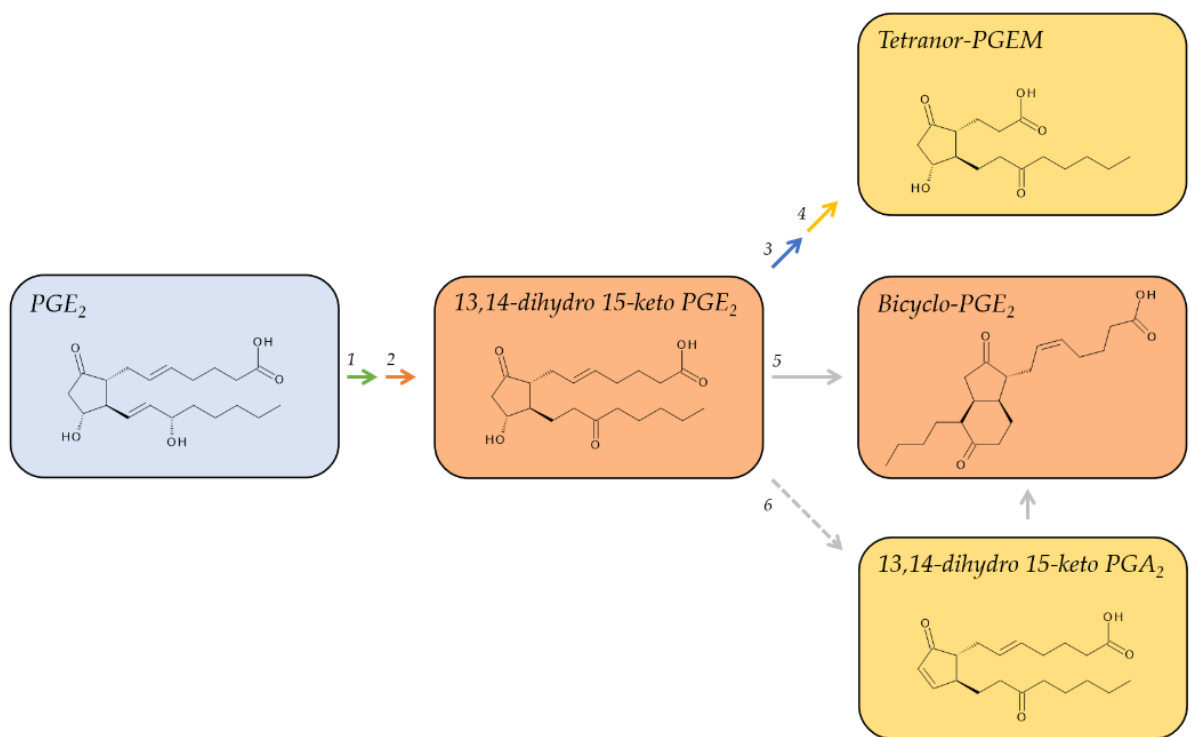
Figure 2. Major metabolic pathway of PGE 2 . Metabolites on a red background are regarded as major plasma metabolites; metabolites on a yellow background are major urinary metabolites. The red arrow indicates reduction, the green, blue, or yellow arrows oxidation, and the grey arrows non ‐ enzymatic/albumin mediated reactions. 1, 15 ‐ hydroxyprostaglandin Dehydrogenase (15 ‐ PGDH, EC 1.1.1.141); 2, 15 ‐ oxo ‐ prostaglandin Δ 13 ‐ reductase (EC 1.3.1.48); 3, enzymatic β‐ oxidation; 4, enzy ‐ matic ω‐ oxidation; 5, non ‐ enzymatic degradation; 6, albumin ‐ mediated degradation.